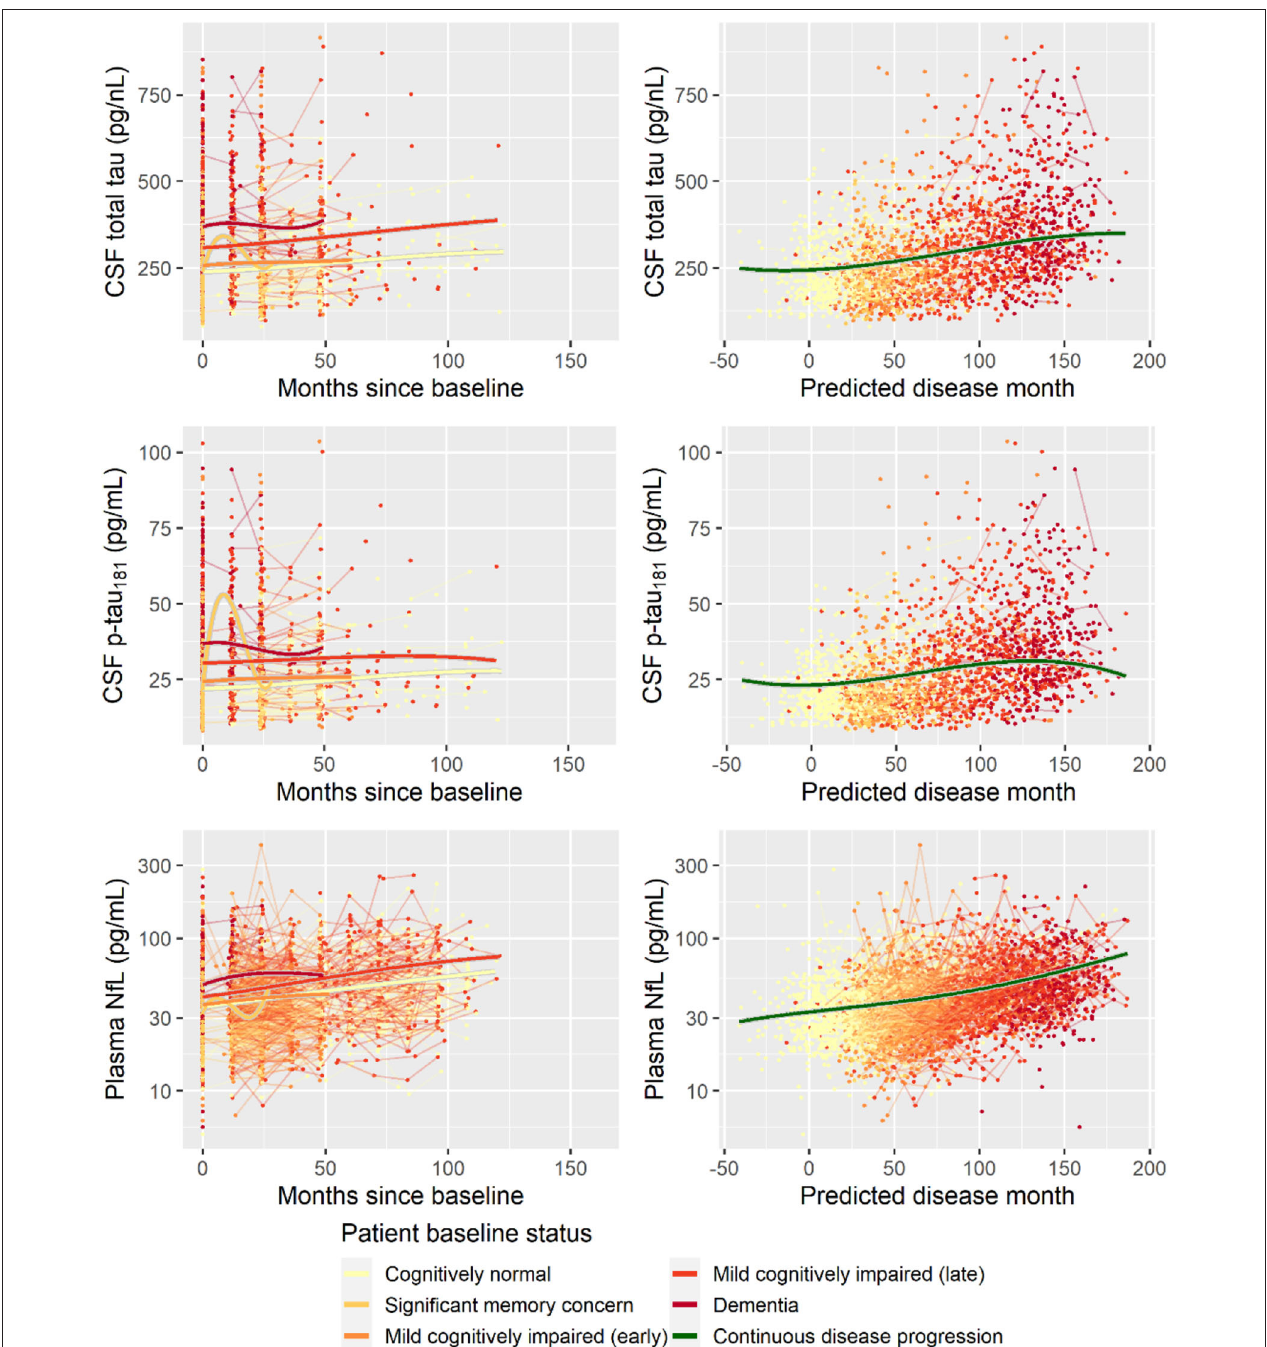
FIGURE 6 | Data and estimated biomarker trajectories for total tau (CSF), p -tau 181 (CSF), and NfL (plasma). Left column shows results when allowing different trajectories for the five baseline groups; right column shows the results when requiring a single trajectory over predicted disease time. Note that the oscillations for the significant memory concern group occur during time periods where no data were collected on the respective